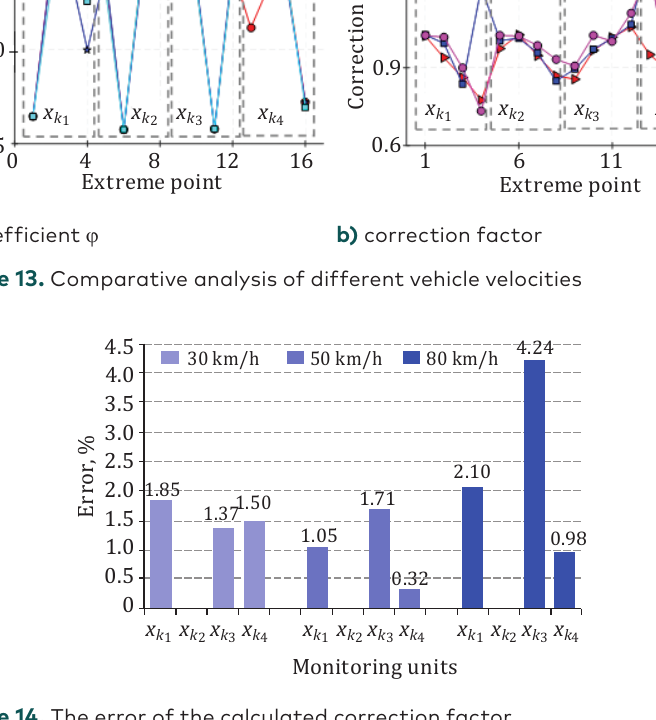
Figure 14. The error of the calculated correction